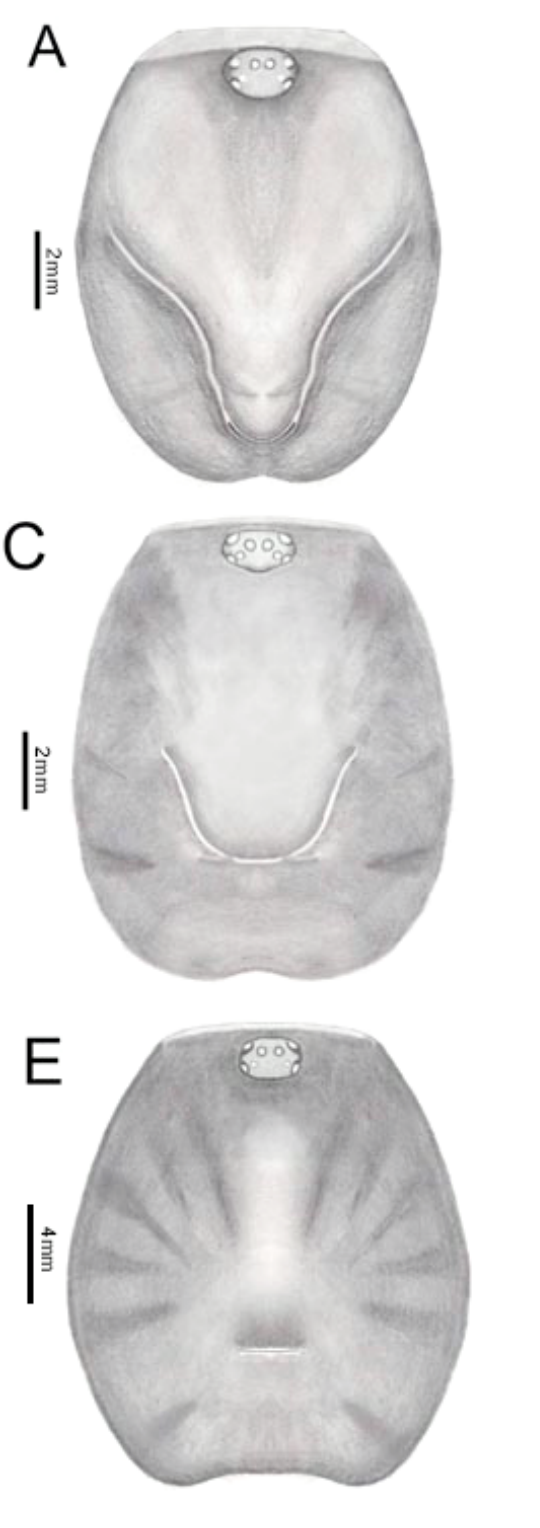
Fig. 5. Fovea, carapace. A . Umbyquyra schimidti gen. et sp. nov. B . U. sapezal gen. et sp. nov. C . U. caxiuana gen. et sp. nov. D . U . cuiaba gen. et sp. nov. E . U. paranaiba gen. et sp. nov. F . U. belterra gen. et sp.